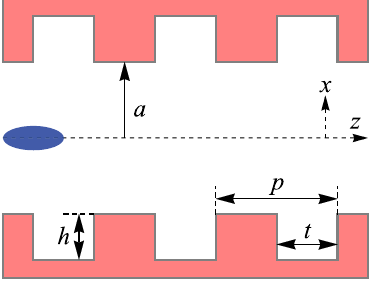
FIG. 1. Three corrugations of a horizontal dechirper. A rec- tangular coordinate system is centered on the symmetry axis of the chamber. The blue ellipse represents an electron beam propagating along the z axis.